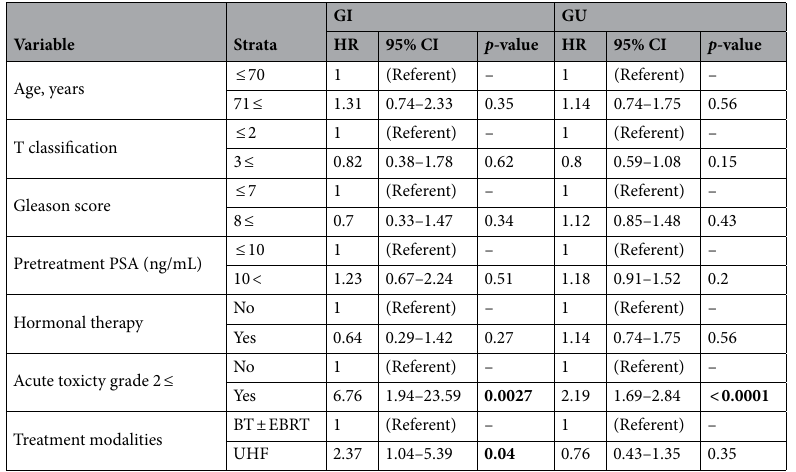
Table 4. Multi-variate analysis for late GU and GI toxicity grade 2 ≤ using Cox proportional hazards model. Bold values indicate statistically significance. Abbreviations; CI confidence interval, HR hazard ratio, NA not available, DeRT dose escalated radiotherapy, UHF ultrahypofractionated radiotherapy, BT brachytherapy, EBRT external beam radiotherapy, UHF ultrahypofractionated radiotherapy.